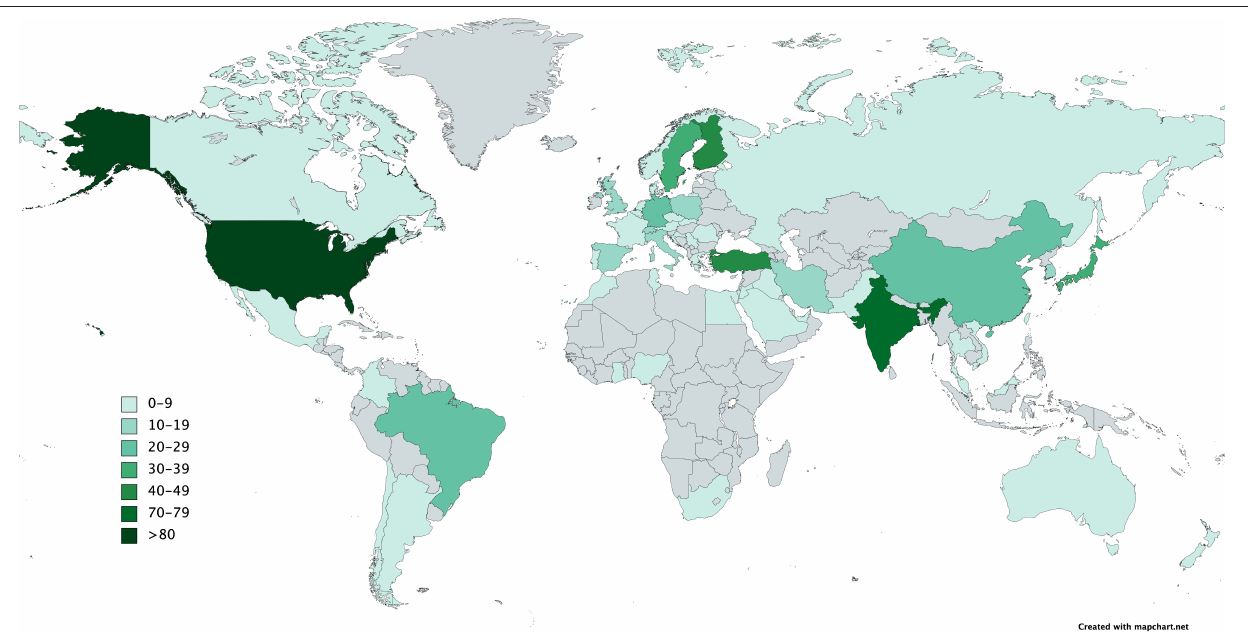
FIGURE 1 | Number of publications per country according to the affiliations of all authors of the PubMed search about saliva, biomarkers, and periodontitis until December 2020.